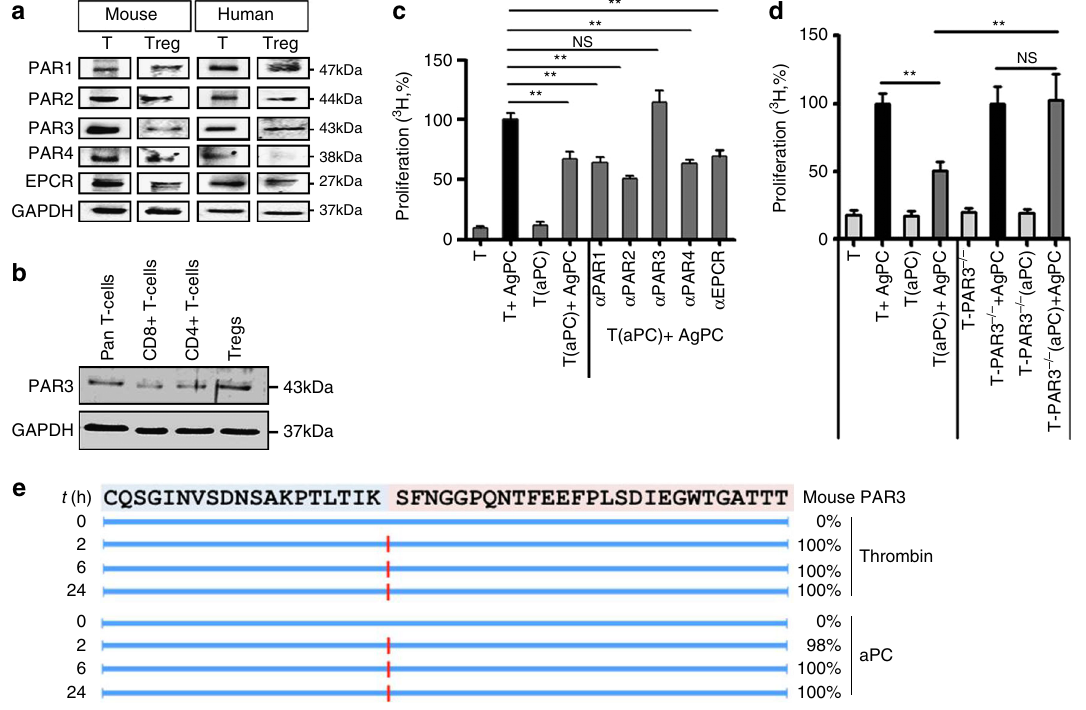
Fig. 6 aPC inhibits allogenic T-cell activation via PAR3. a Expression of PARs and EPCR on human and mouse pan T-cells (T) and regulatory T-cells (T reg ) was determined by immunoblotting. GAPDH was used as loading control. Exemplary immunoblots of three independent repeat experiments. b Expression of PAR3 in human pan T-cells, CD8 + T-cells, CD4 + T-cells, and T regs (CD4 + CD25 + ). Exemplary immunoblots of three independent repeat experiments. c Preincubation of human peripheral blood T-cells (T) with N-terminal binding antibodies against PAR3 ( α PAR3), but not against PAR1 ( α PAR1), PAR2 ( α PAR2), or PAR4 ( α PAR4), or with an EPCR blocking antibody ( α EPCR) prior to aPC-preincubation and MLR abrogates aPC ’ s inhibitory effect in regard to T-cell reactivity. d Preincubation of T-cells (T) from C57BL/6 PAR3-de fi cient (PAR3 − / − ) mice with aPC and subsequent allogenic stimulation (T-PAR3 − / − (aPC) + AgPC) abrogates aPC ’ s inhibitory effect on T-cell reactivity. e Proteolytic fragments (indicated by red lines ) observed following incubation of the N-terminal end of mouse PAR3 (sequence shown at the top ) with human thrombin (10 nM) or human aPC (500 nM). Proteolysis was determined at indicated time-points ( left , t(h)) and estimated cleavage ef fi ciency is shown in percentage ( right ). Mean value ± SEM ( c , d ), results of at least three repeat experiments each with three biological disjunct donors. ** P < 0.01 ( c , d :